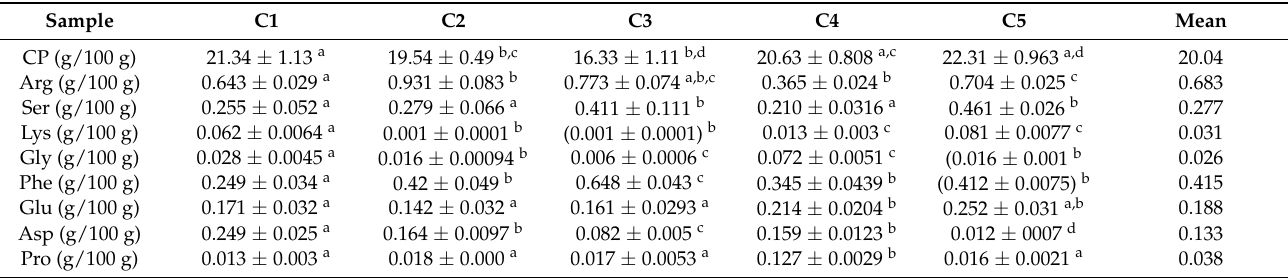
Table 4. Crude protein and amino acid